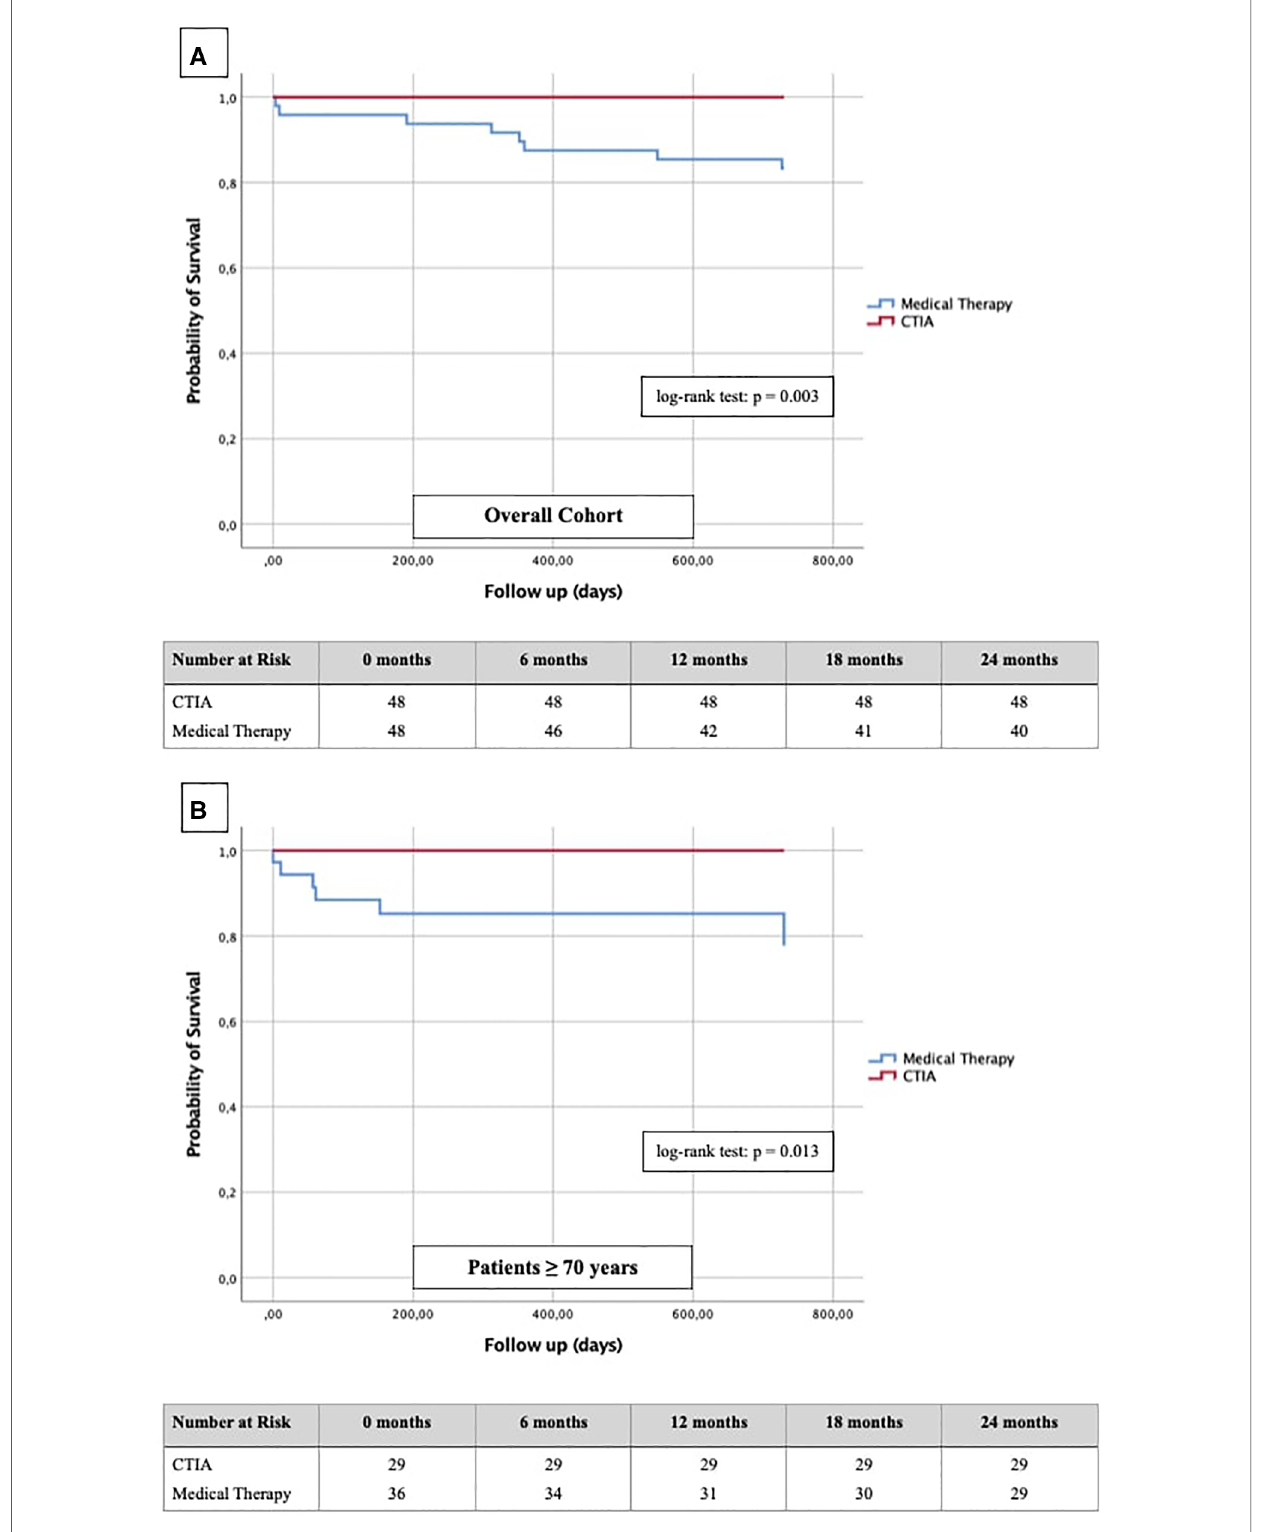
FIGURE 7 Kaplan-Meier curves with corresponding numbers at risk for detection of 2-year survival regarding cardiovascular death in dependence of ablation vs. medical therapy.